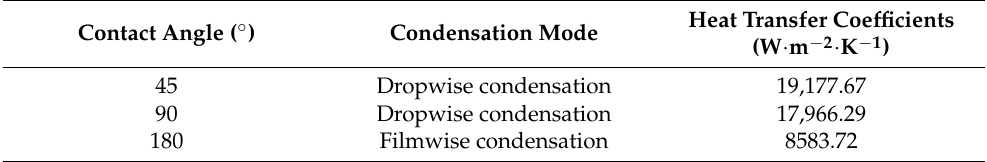
Table 3. Comparison of heat transfer coefficients between filmwise condensation and dropwise condensation.